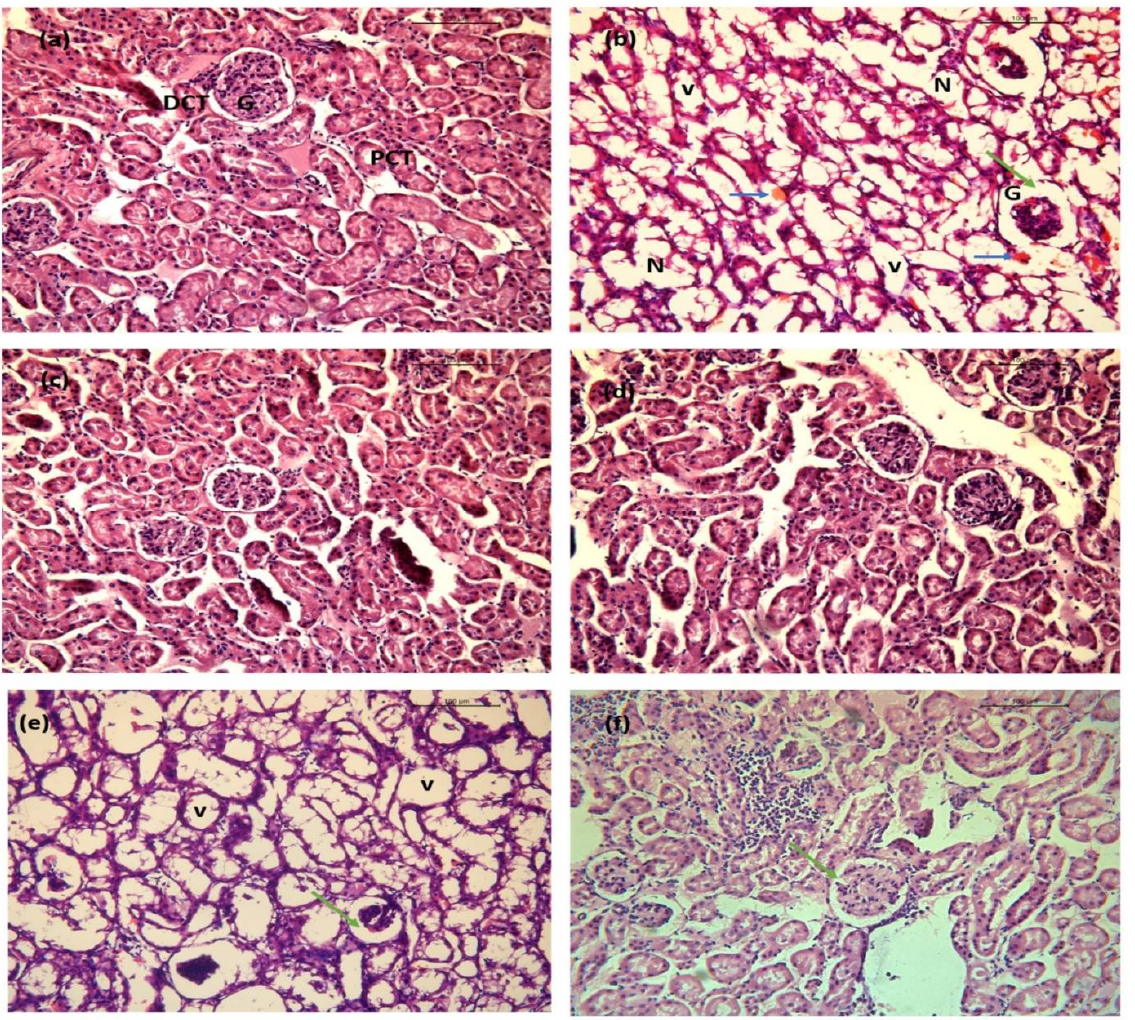
Figure 16. Images represent the BGG protection on LPS-induced sepsis model in mice. Hematoxylin and eosin (H&E)-stained kidneys. ( a ) Saline showing normal morphological structure with glomerulus (G), proximal convoluted tubules (PCT), and distal convoluted tubules (DCT). ( b ) Lipopolysaccharide (LPS) endotoxin showing severe degenerative alterations with tubular necrosis (N), vacuolation of renal tubules (V), enhancement of Bowman’s space (green arrow), hemorrhage in interstitial tissue (blue arrow). ( c , d ) BGG 20 mg/kg and 40 mg/kg showing no significant pathological alteration. ( e ) LPS + BGG 20 showing moderate tubular degeneration with reduction of Bowman’s space (green arrow). ( f ) LPS + BGG 40 showing the normal glomerular structure and Bowman’s space with mild vacuolation of renal tubules.